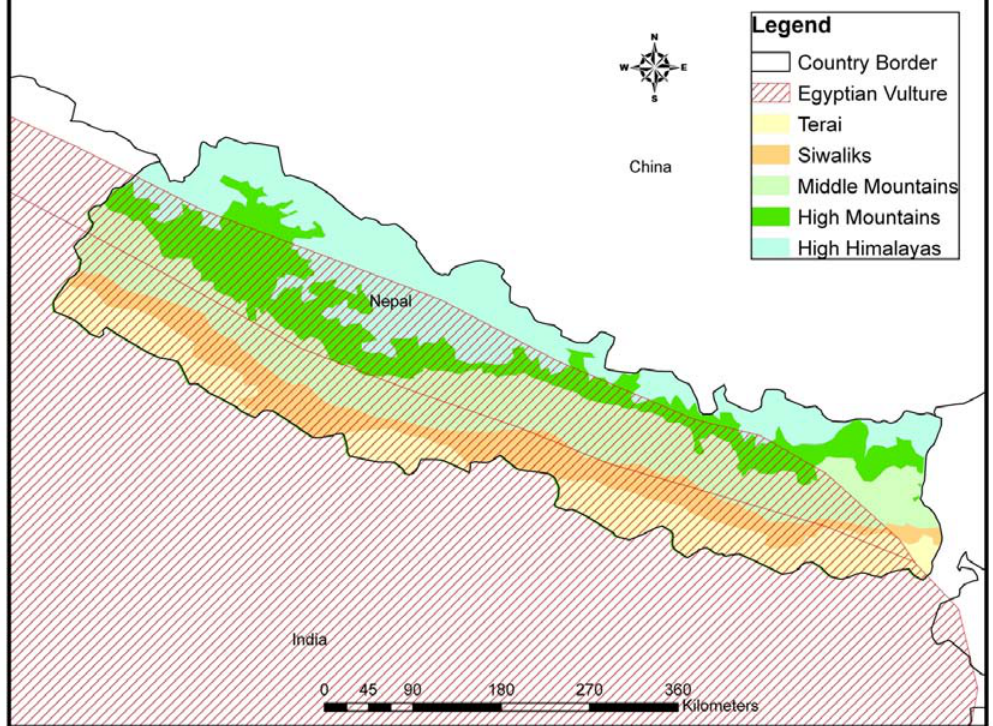
Figure 8. Egyptian Vulture distribution in Nepal. Adapted from (Birdlife International & NatureServe